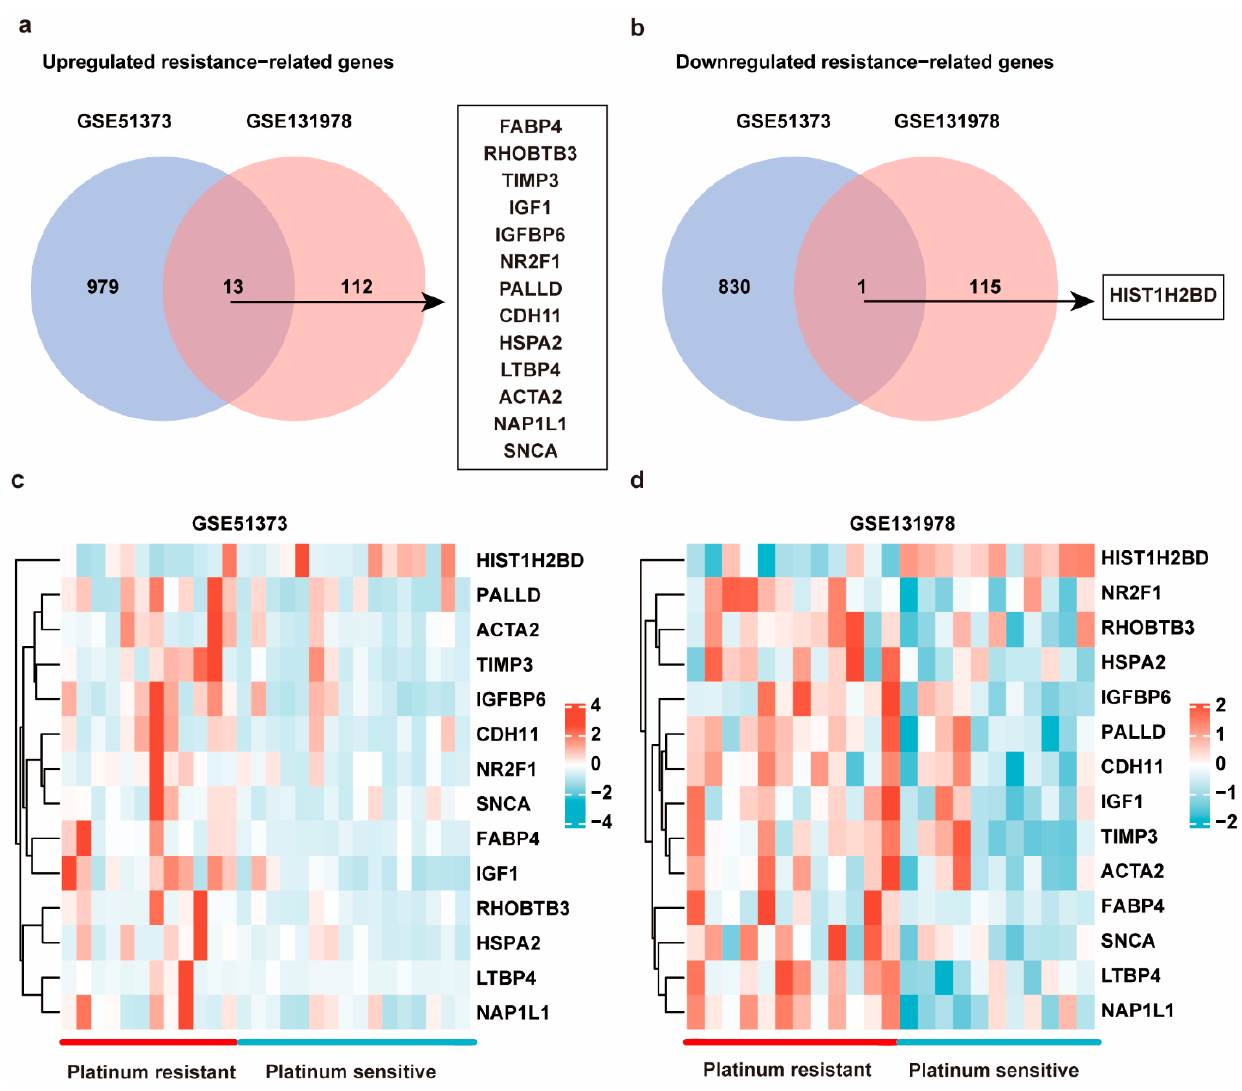
Figure 1. The common differential expressed genes (co-DEGs) associated with platinum resistance between GSE51373 and GSE131978. ( a ) Thirteen co-upregulated platinum-resistant-related genes (FABP4, RHOBTB3, TIMP3, IGF1, IGFBP6, NR2F1, PALLD, CDH11, HSPA2, LTBP4, ACTA2, NAP1L1, and SNCA) were identified in ovarian cancer (OC) tissues. ( b ) One co-downregulated gene (HIST1H2BD) was identified in OC tissues. ( c , d ) Heatmaps of 14 co-DEGs between platinum-resistant and sensitive tissues.